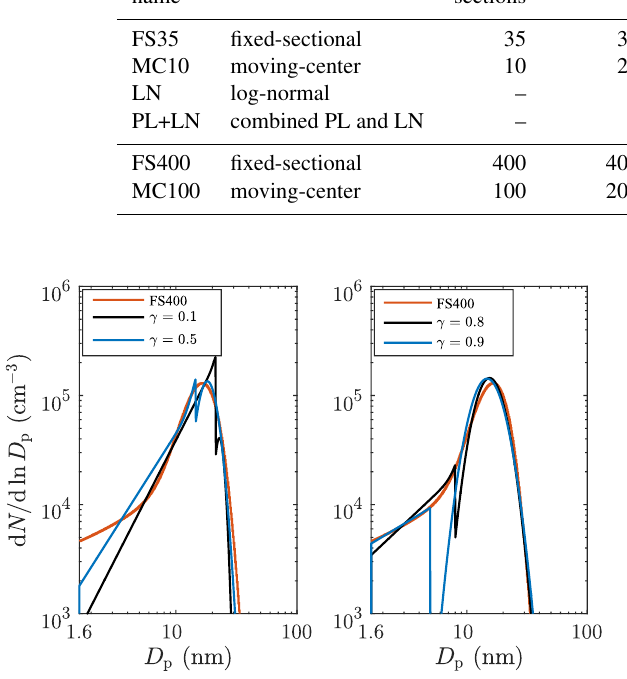
Figure 14. Particle size distributions 978s after the UV lights were switched on, with the different values for the condensational trans- fer factor γ using the PL + LN model compared to the FS400